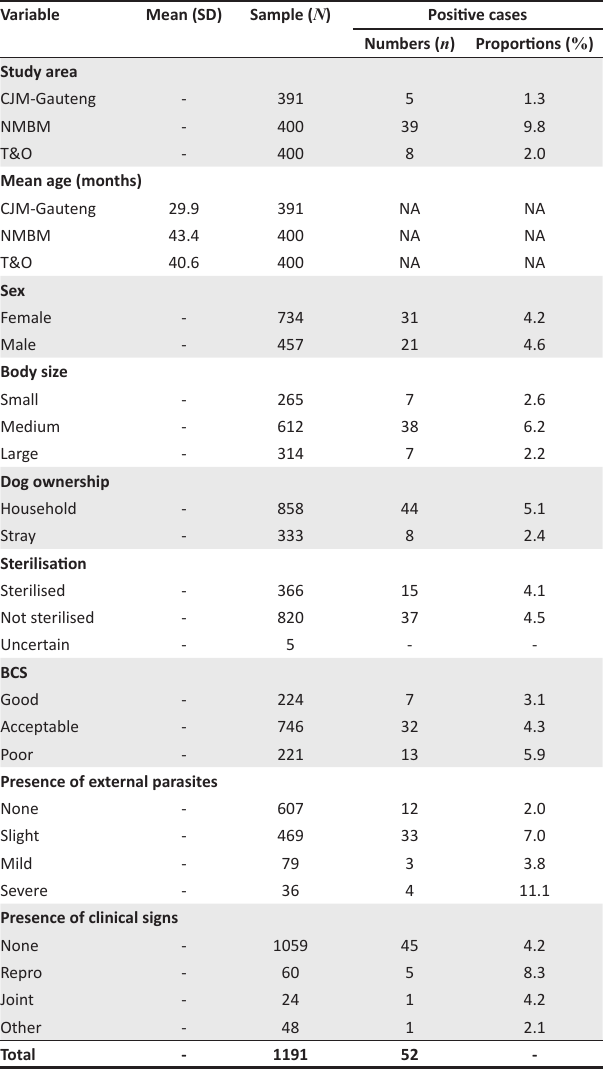
TABLE 1: The proportion of Brucella canis positive cases in the study area.